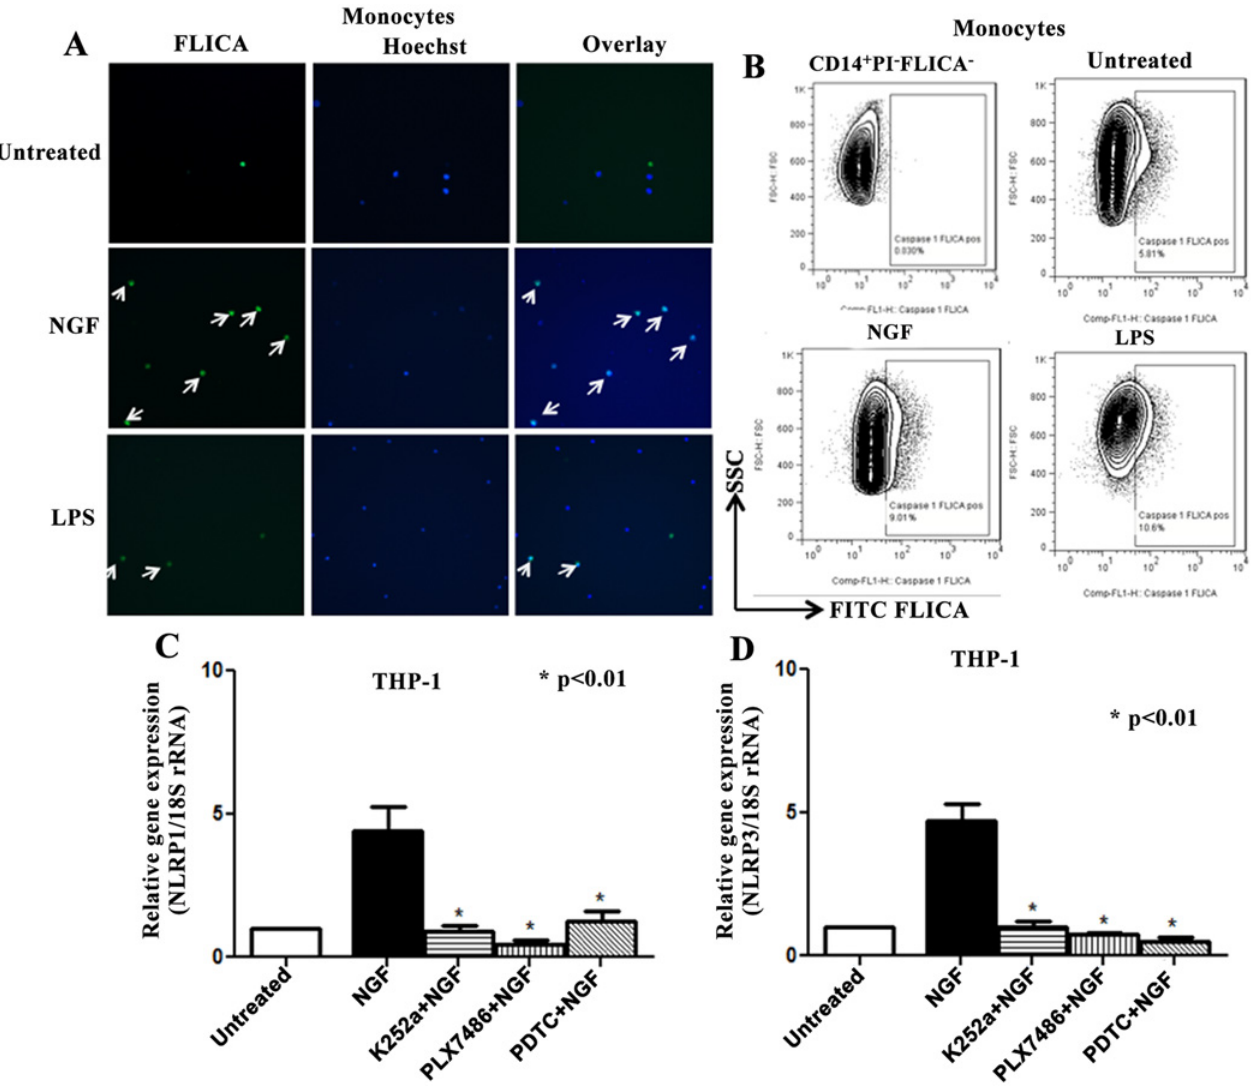
Fig 2. NGF induces activation of caspase-1 through NLRP1/NLRP3 inflammasomes in monocytic cell line. (A) Magnetically sorted human monocytes (n = 8) were cultured 24 hrs with NGF (100 ng/ml) and activated caspase-1 was determined using FLICA kit. Representative immunofluorescent images (20x, Leica Microscope) showing more FLICA + positive monocytes in NGF treated culture compared to untreated. (B) Monocytes cultured in similar settings with FLICA were subjected to flow cytometry to determine activated caspase-1 using FlowJo. First representative histogram is the stain-1 for FLICA using PI - cells. NGF treatment showed more FLICA + monocytes compared to untreated control. (C) Real-time PCR was done with extracted total RNA from null THP-1 cells cultured 24 hrs with or without NGF (100 ng/ml), K252a (100 ng/ml), PLX7486 (100 ng/ml) and PDTC (50 μ M). 18S rRNA was used as an endogenous control. NGF significantly upregulated mRNA of NLRP1, which is effectively blocked by K252a, PLX7486 and PDTC (n = 6). (D) In similar setting, NGF/TrkA interaction significantly upregulated mRNA of NLRP3 in a NF- κ B dependent manner (n = 6). Data expressed as Mean ± SEM. Mann Whitney U test was done to determine statistical